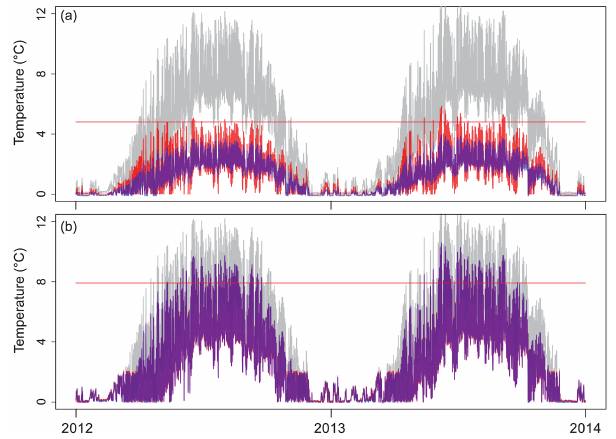
Figure 5. Hourly stream temperatures estimated using Fourier de- composition (red) and linear regression (purple) at site A and B (plots (a) and (b) , respectively) and temperature at the reference site (grey). Horizontal red line represents the maximum tempera- ture recorded from the monthly spot measures (4.8 ◦ C on 5 June 2013 at site A, and 7.9 ◦ C on 9 July 2013 at site